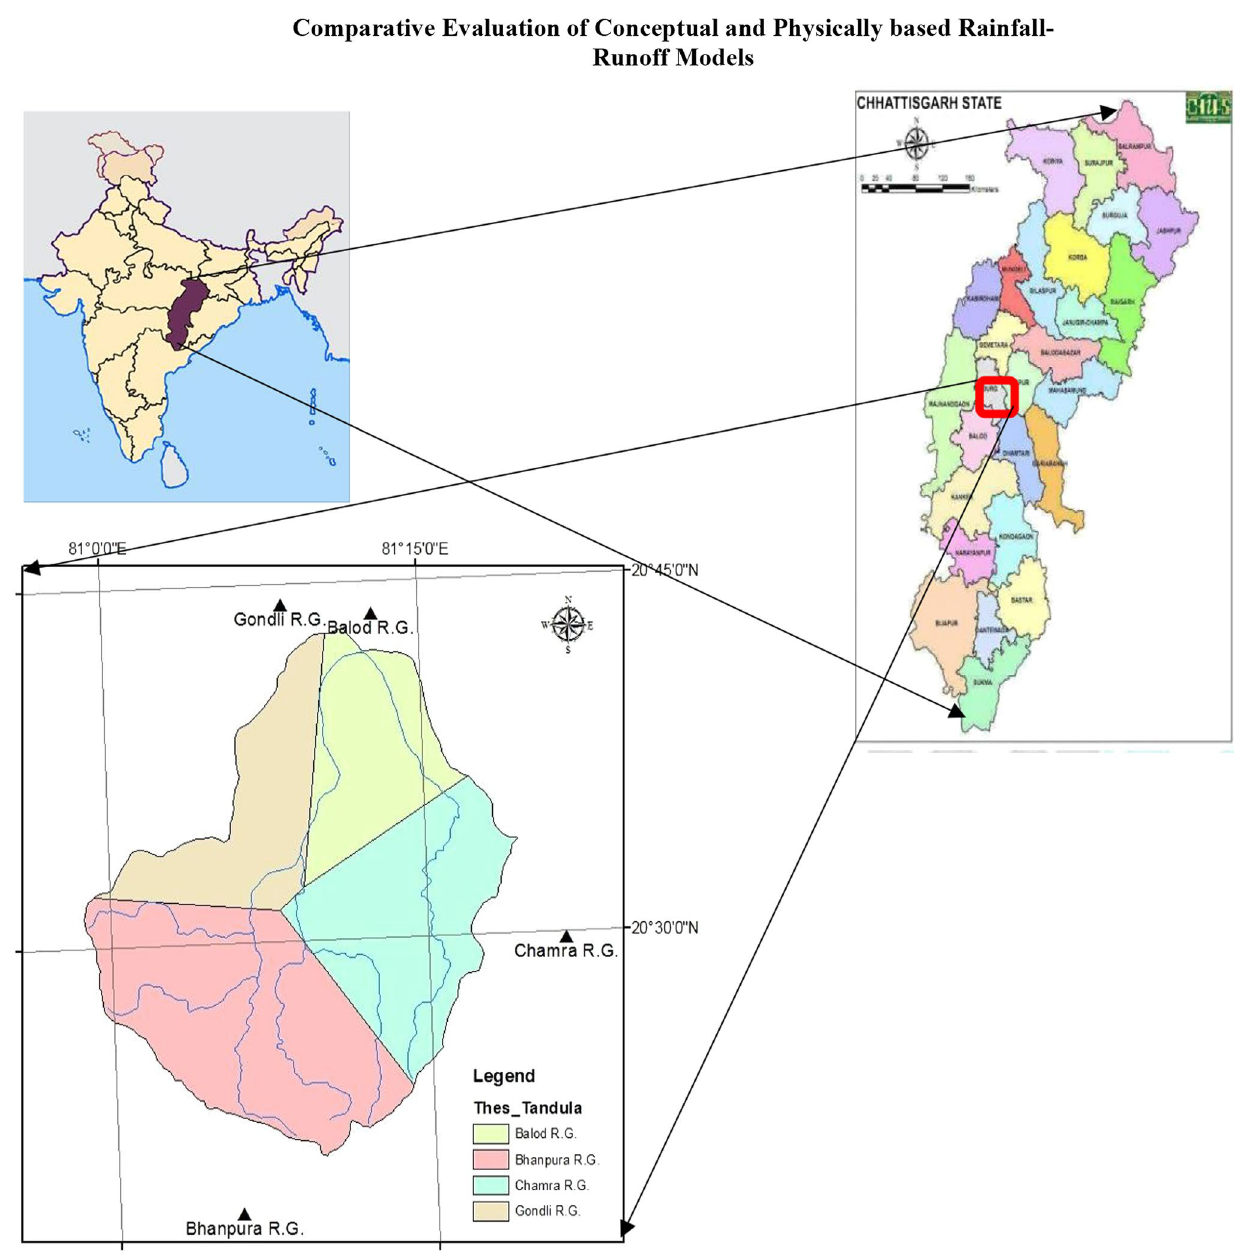
Fig. 1 Location map of Tandula catchment in Chhattisgarh state of